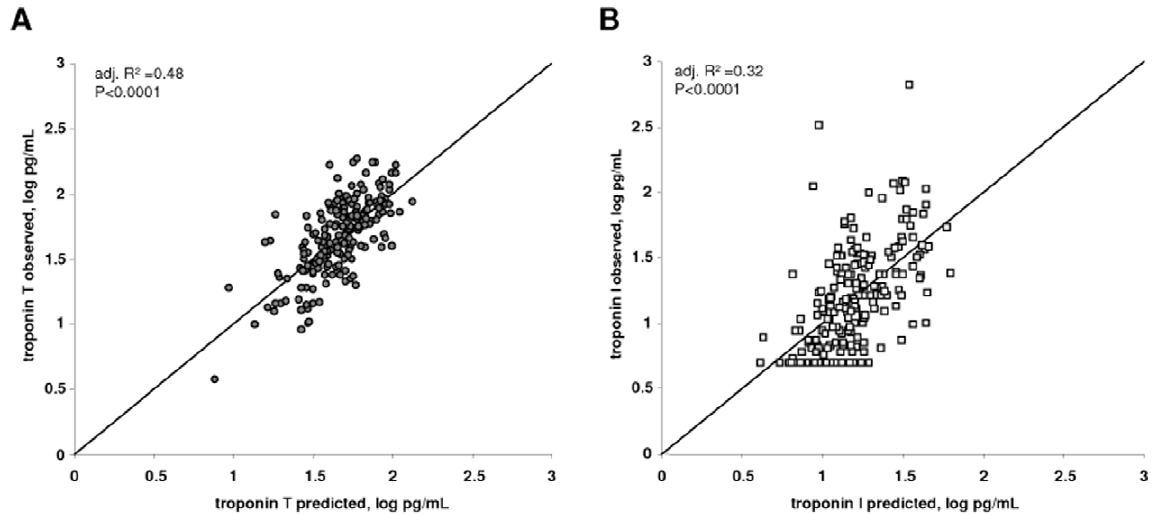
Figure 3. Agreement between predicted and observed log troponin I and T concentrations. Plot of the predicted and observed troponin values for troponin T ( A ) and troponin I ( B ) as a result of the models shown in table 4. The diagonal line represents the line of identity.